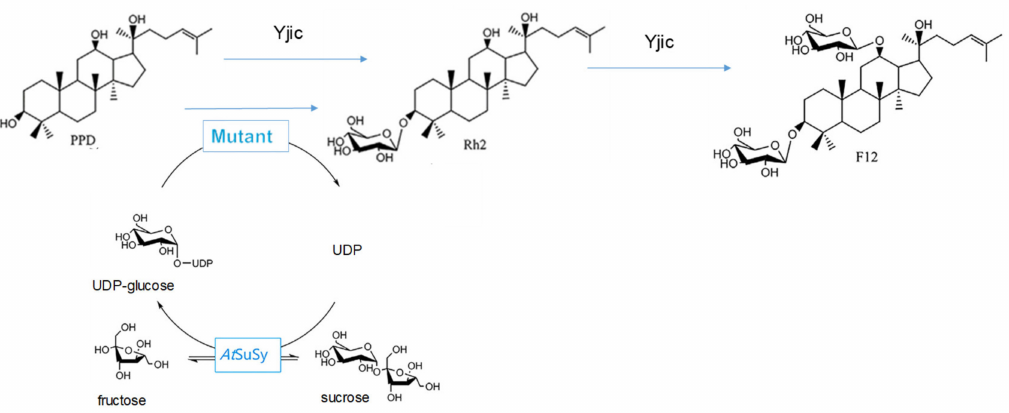
Figure 5. Cascade enzymatic process for Ginsenoside Rh2 synthesis. Figure was reprinted from Ref. [45]. Copyright © 2020, Elsevier.